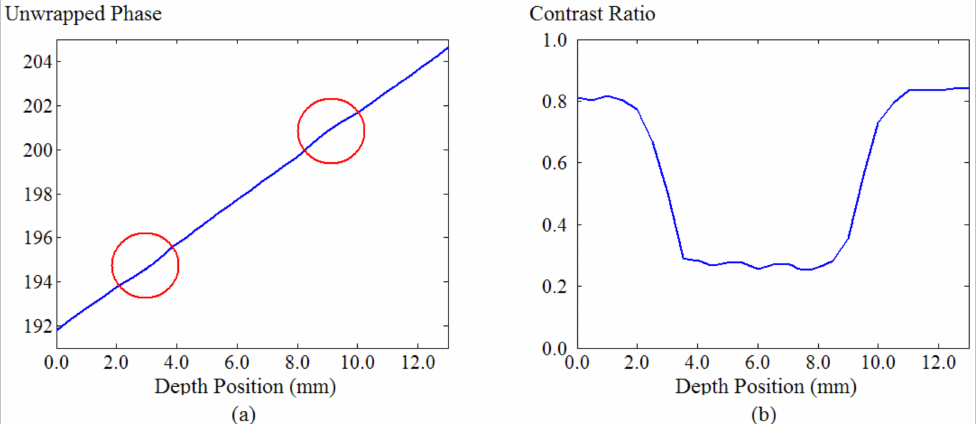
Figure 7. ( a ) A correspondence between the unwrapped phase and the depth position for one selected image pixel. ( b ) Correspondence between the fringe contrast and the depth position (for the same image pixel).